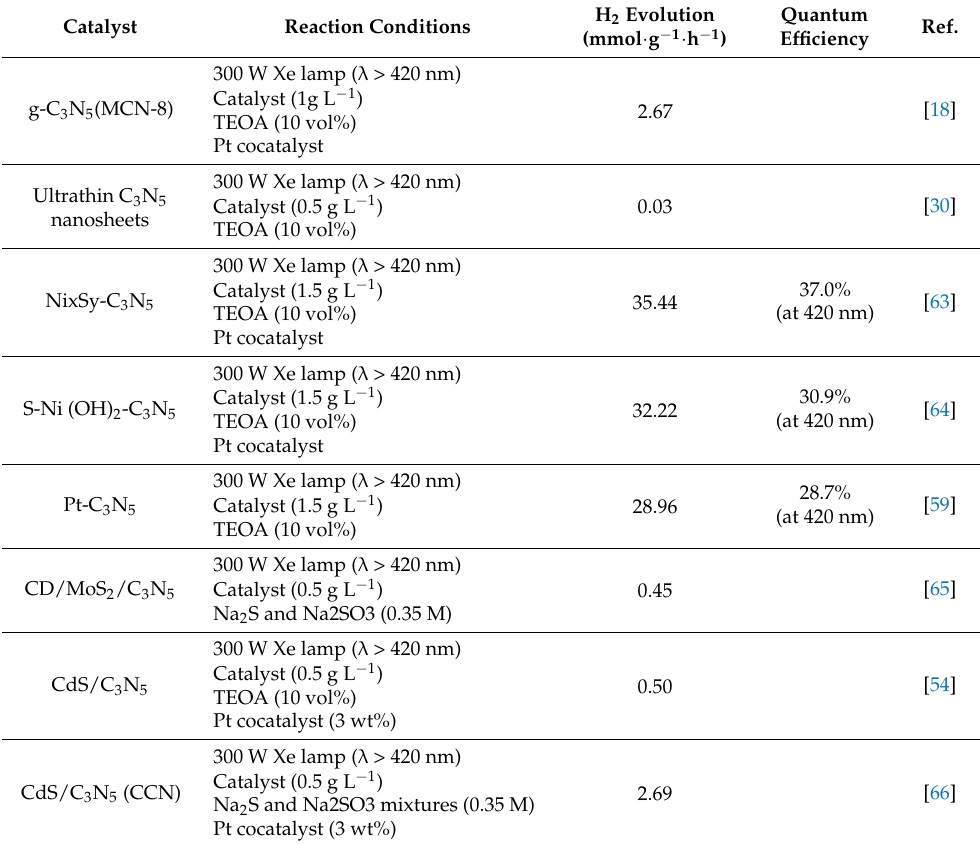
Table 1. Summaries of g-C 3 N 5 composite materials on photocatalytic H 2 production.